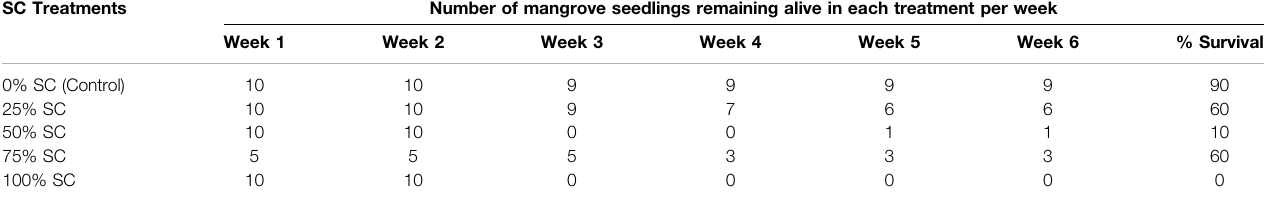
TABLE 1 | Mangrove seedling survival in ‘ wet ’ nursery conditions showing the death of the plants (0% survival) by week 3 in 100% Sargassum spp. compost (SC). The experiment was terminated after week 6 when one treatment had death of all plants. SC Treatments